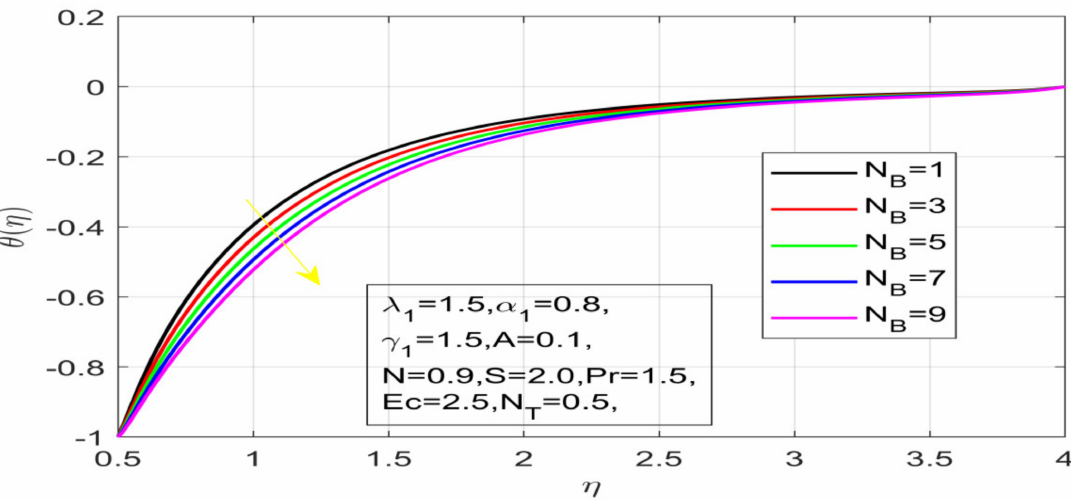
Figure 13. Influence of N_B on